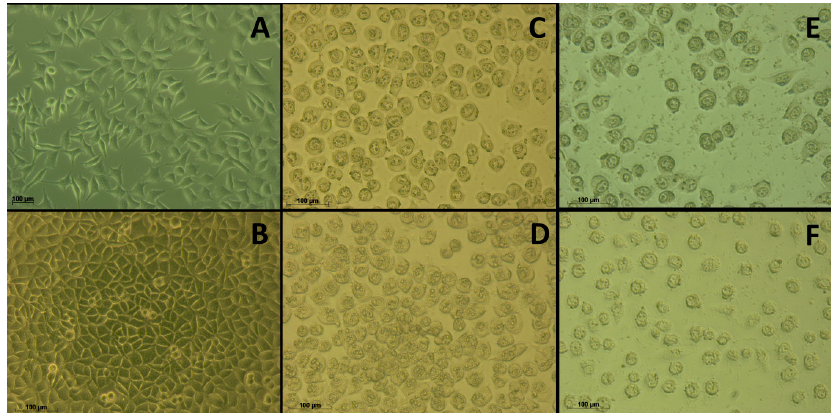
Figure 3. Micrography of MCF ‐ 7 cells treated with peptide 26 [F] at 100 μ g/mL. The cells were incubated in the absence ( A ) or the presence of the peptide at ( B ) 5 min, ( C ) 90 min, ( D ) 240 min, ( E ) 24 h, and ( F ) 48 h at 37 ◦ C. The cell size was determined as an average of 100 measurements, using an AxioCam ICc1 camera.